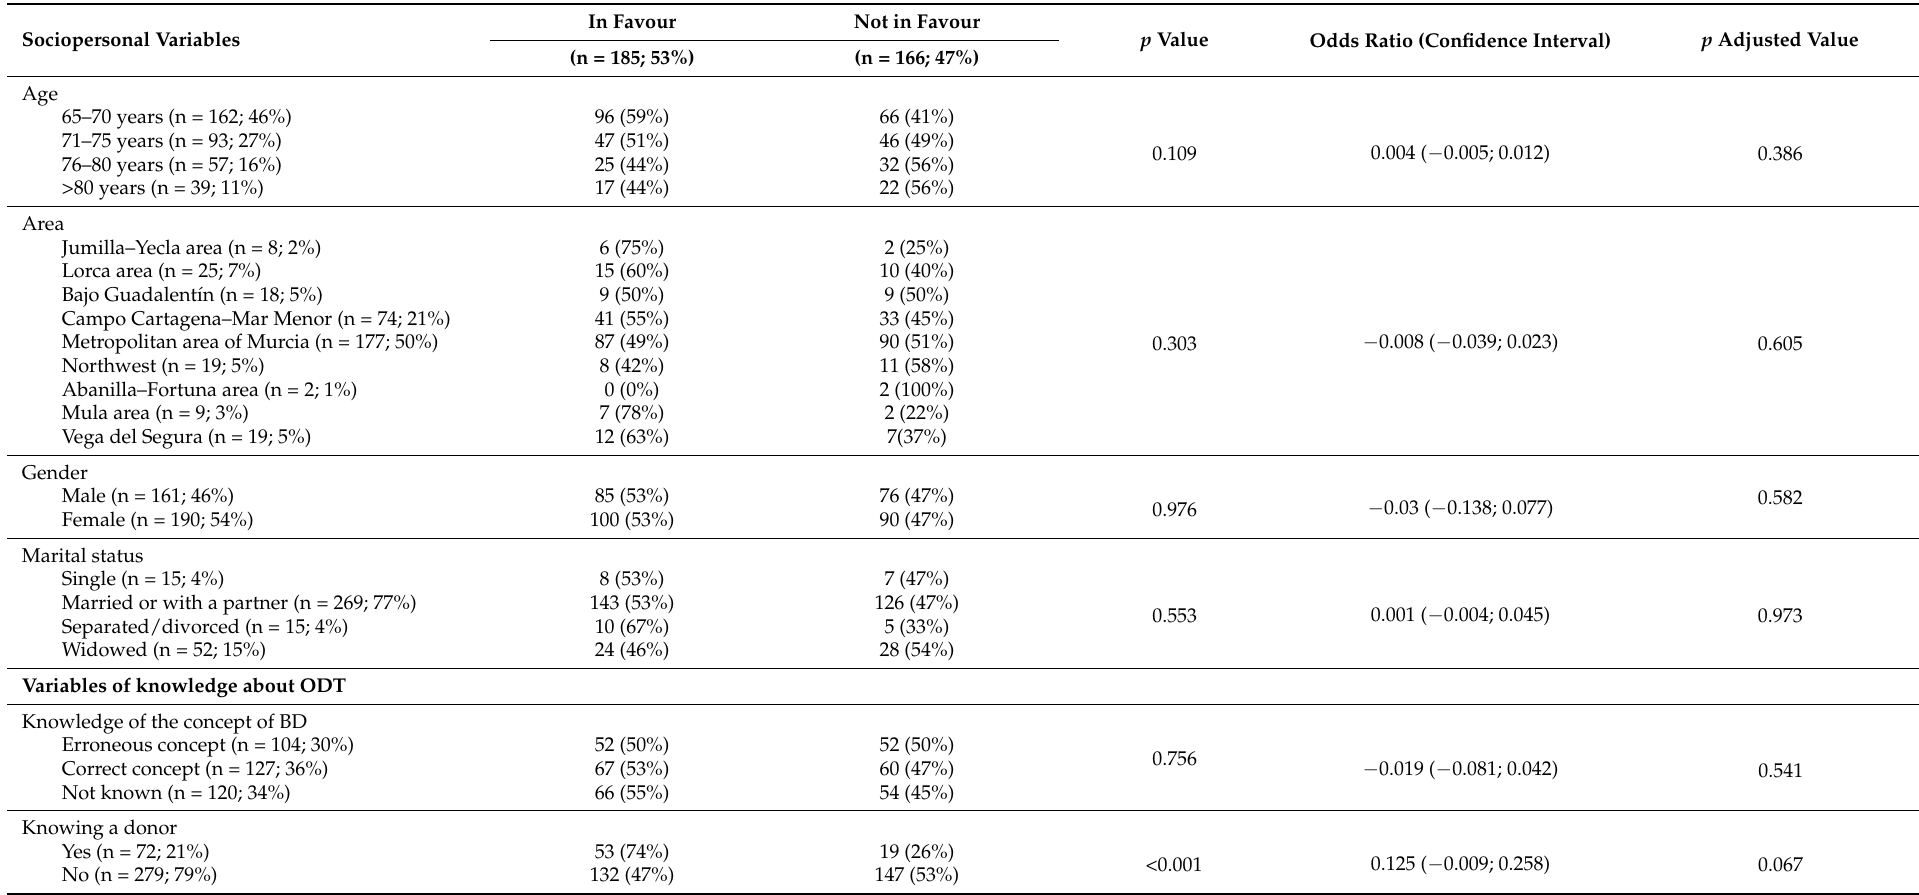
Table 3. Analysis of the influence of the sociopersonal variables on attitude toward the donation of one’s own organs upon death and of the variables of knowledge and social/family interaction about ODT on attitude to the donation of one’s own organs upon